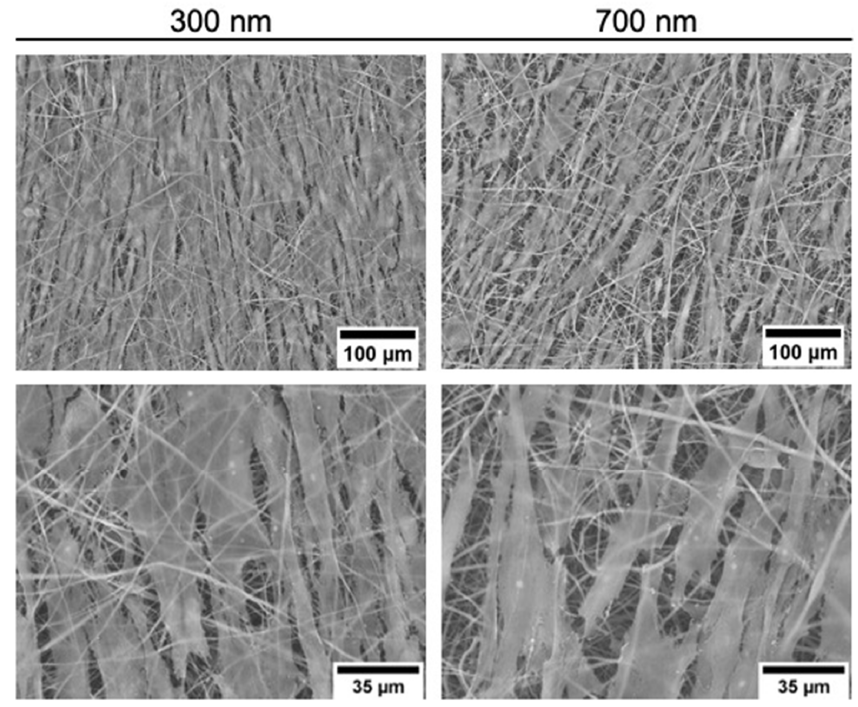
Figure 8. Representative SEM images of uncoated PCL scaffolds (300 and 700 nm) seeded with human iMSCs for 15 days.